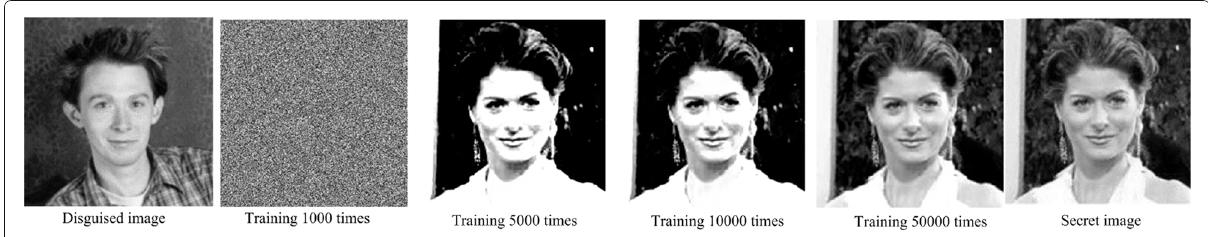
Fig. 5 The sensory effects of generated images at different iterations